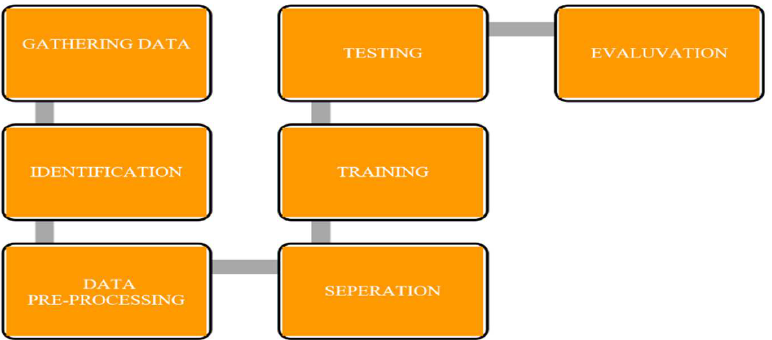
Figure 2. Steps involved in machine